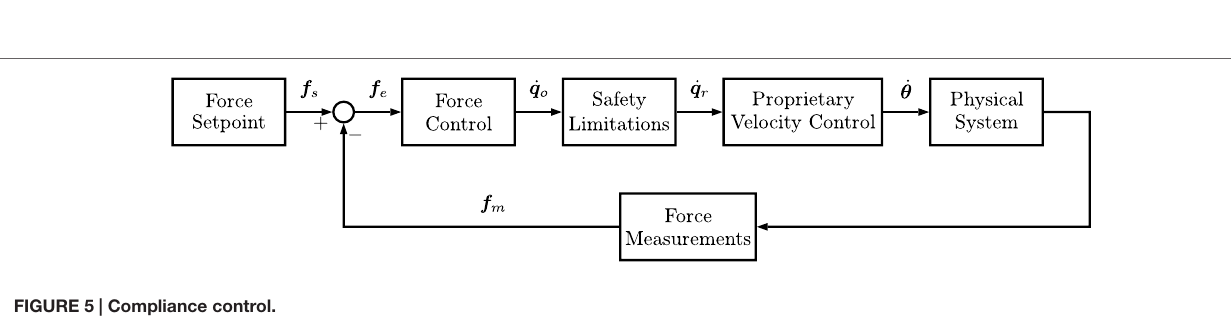
FigUre 4 | The dexterous workspace for the robot. The probe should be able to have any orientation within a cone with an arc of 120°, and this defines the dexterous workspace. In (a–c) , no tool is attached to the robot; and in (D–F) , the ultrasound tool is used.